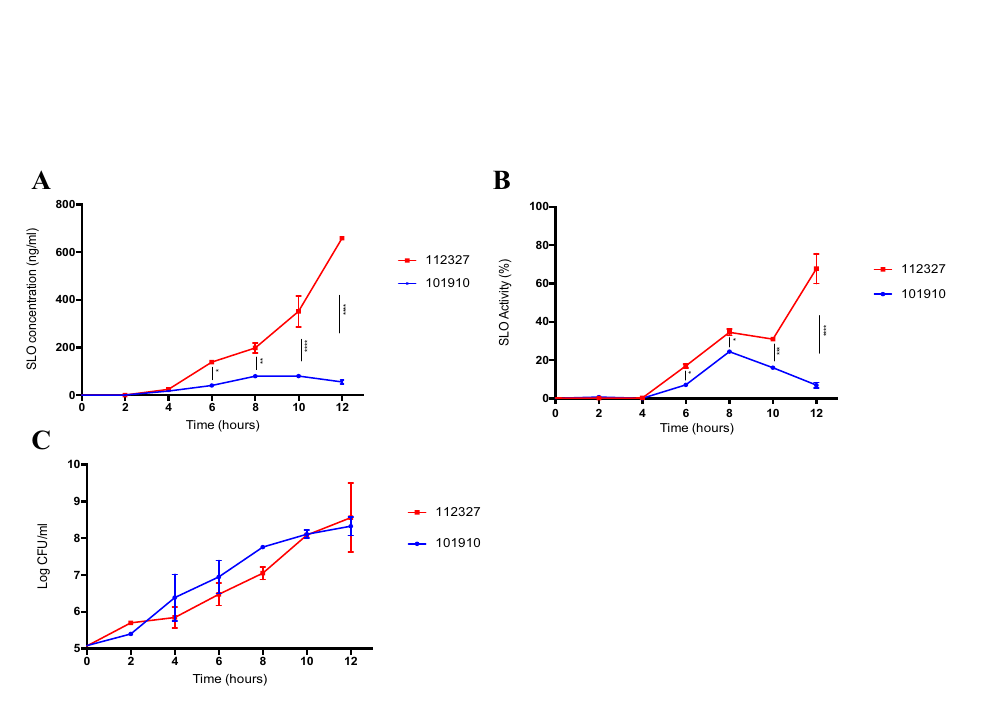
Figure 3. Comparison of streptolysin production and activity in emm type 32.2 and emm type 1.0. ( A ) Concentration of streptolysin (ng/ml) secreted into the supernatant by emm type 32.2 (isolate 112,327) and emm type 1.0 (isolate 101,910) over time, measured by a custom made SLO-ELISA. ( B ) SLO haemolytic activity and ( C ) growth kinetics of isolates displayed as CFUs. *p value < 0.05, **p value < 0.01, ***p value < 0.005, and ****p value < 0.001 when analysed using a two-way ANOVA followed by a Bonferroni’s multiple comparisons